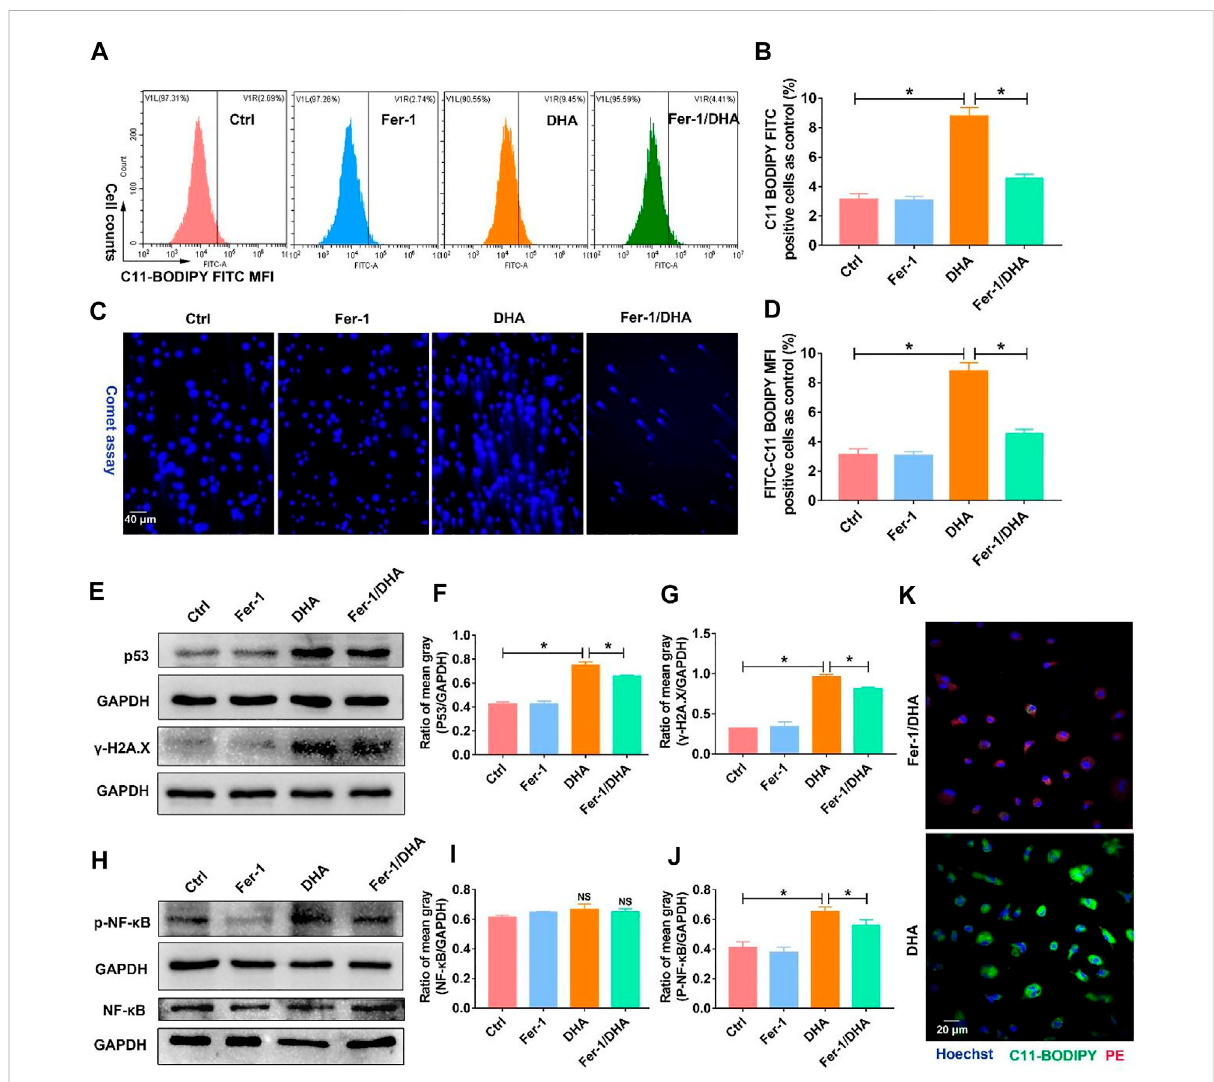
FIGURE 7 Inhibition of ferroptosis using Fer-1 reduced the DNA damage and activation of NF- κ B triggered by DHA. (A,B) The LPO generation, which re fl ected the ferroptosis of TAM, was assayed using the C11-BODIPY probe. The cellular LPO fl uorescence (FITC) was measured through fl ow cytometry. (C,D) The DDSB was assayed by comet experiments. The comet tail length was counted. (E – G) The expression of p53 and γ -H2A.X, and comet assay were detected to con fi rm the degree of DNA damage. The results were quantitatively analyzed using mean gray. (H – J) Activation of NF- κ B was assayed through the expression of p-NF- κ B in TAM. The results were quantitatively analyzed using the mean gray. (K) The LPO generation, which was assayed using the C11-BODIPY probe, was observed by confocal microscopy. Green fl uorescence represented LPO accumulation. Values were means ± SD ( n = 3, * p <